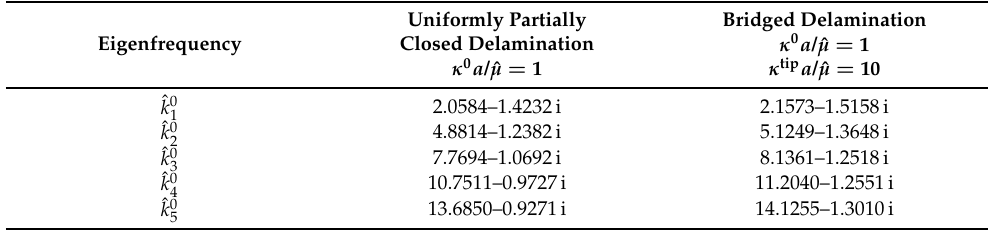
Table 5. Eigenfrequencies ˆ k 0 n for uniformly distributed and bridged delaminations in a homogeneous space